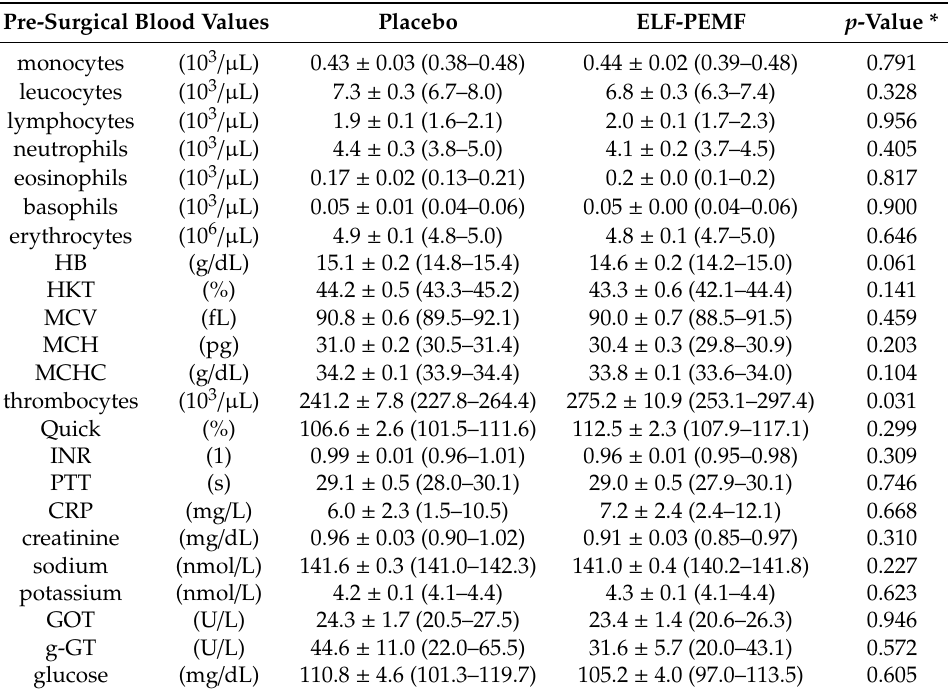
Table 2. Data on full blood cell counts taken prior to